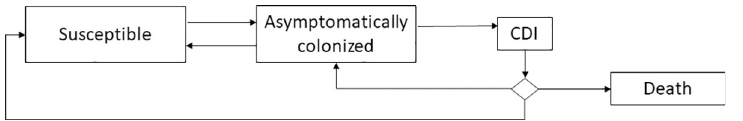
Fig 1. Clostridioides difficile natural history states (CDI: Clostridioides difficile